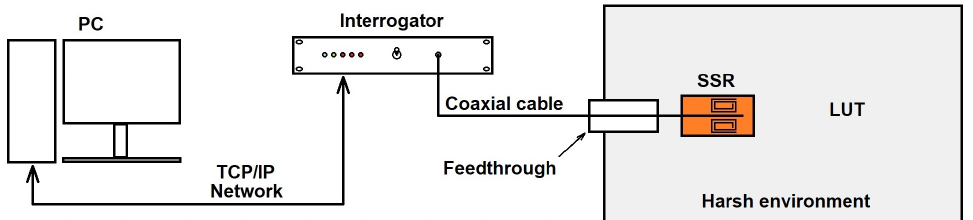
Figure 14. Sketch of the high-pressure and high-temperature measurement